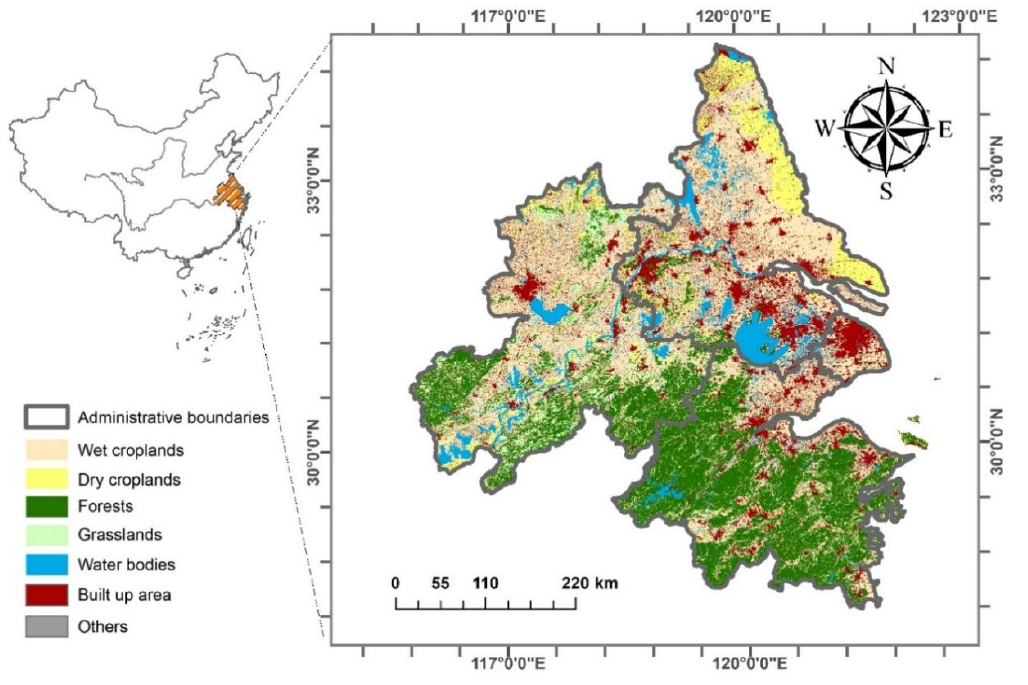
Figure 1. The location and land use of the study area.